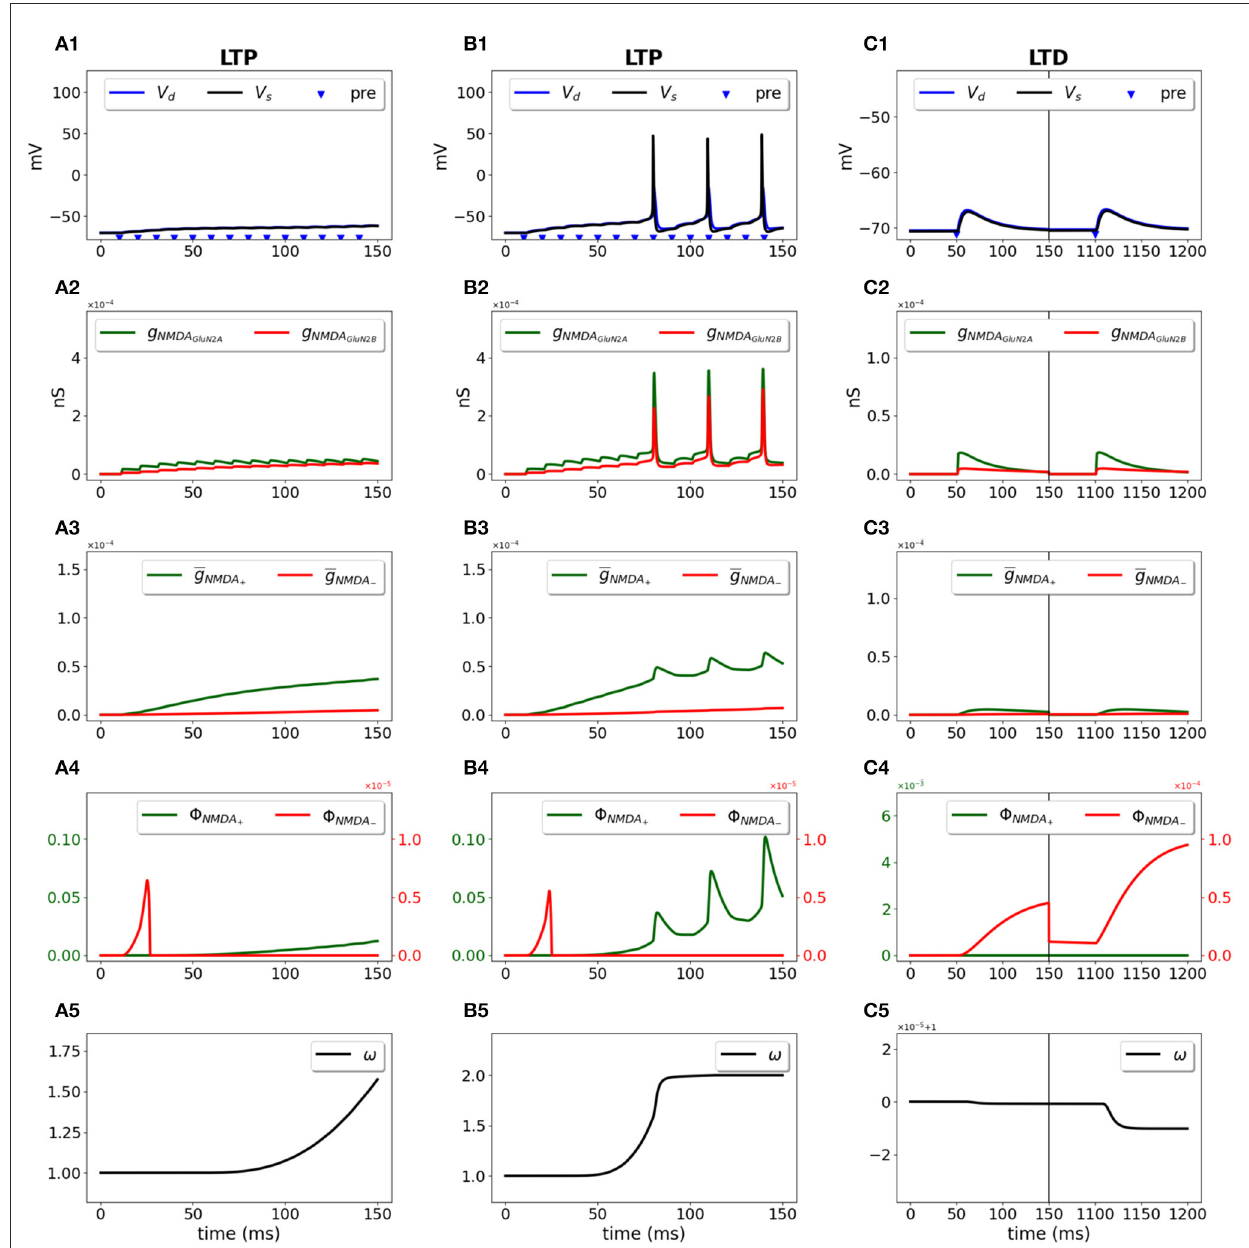
FIGURE5 Synaptic weight change for the frequency-dependent subthreshold LTP (A1–A5) , suprathreshold LTP (B1–B5) , and LTD (C1–C5) protocols using a two-compartment model of CA1 pyramidal neuron. Presynaptic input was stimulated at 100 Hz for 1 s (LTP protocol) or at 1 Hz for 100 s